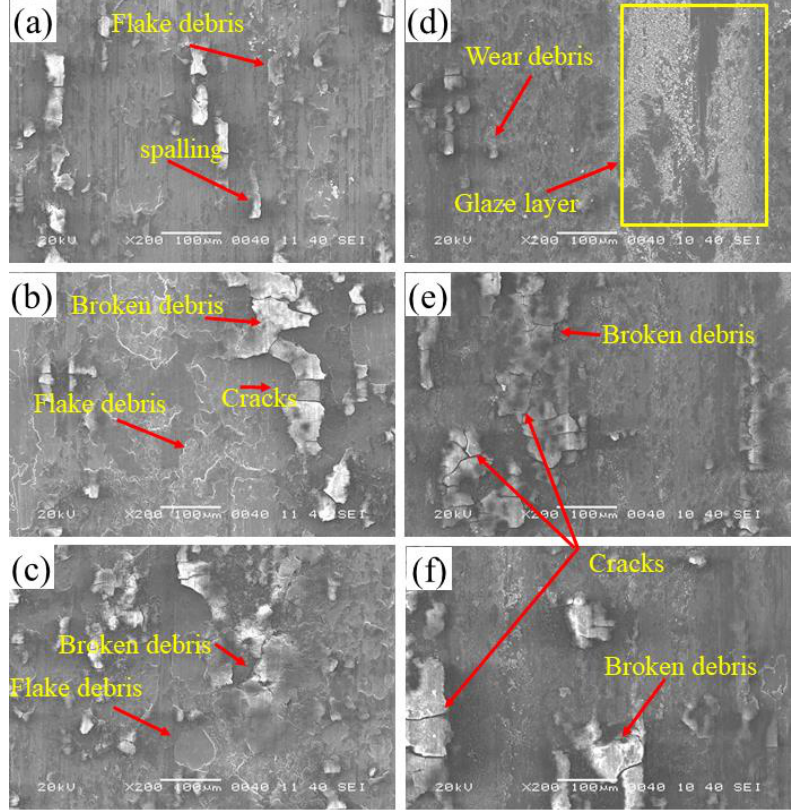
Figure 10. SEM micrographs of the worn surface under different loads: 20 N ( a , d ); 30 N ( b , e ); 40 N ( c , f ). ( a – c ) Images of the HX1 coating; ( d – f ) images of the HX2